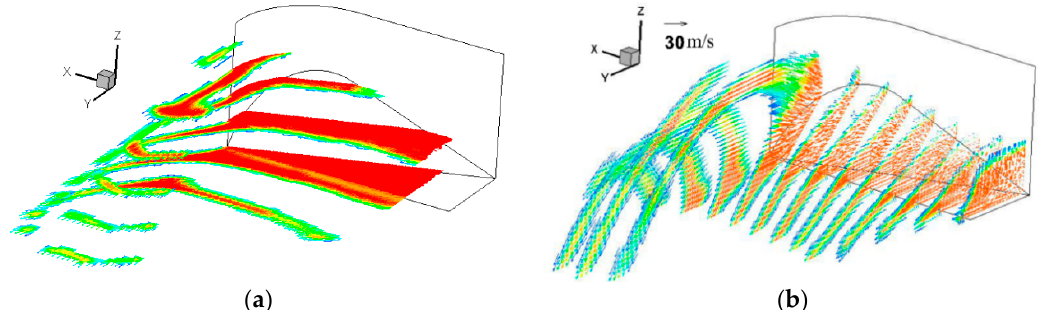
Figure 5. Jet diffusion of streamwise-lateral ski-jump flow (simulated results for α = 45°): ( a ) water profile at different elevations; ( b ) velocity vector profile at different cross-sections.